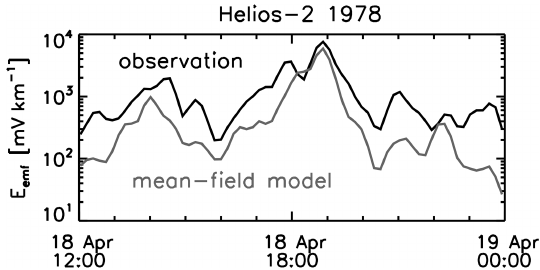
Figure 6. Distribution of peak values of electromotive force (as a magnitude) as a function of radial distance from the Sun for shock crossing events in the Helios-1 and Helios-2 data. Figure is pro- duced using the data in Hofer and Bourdin